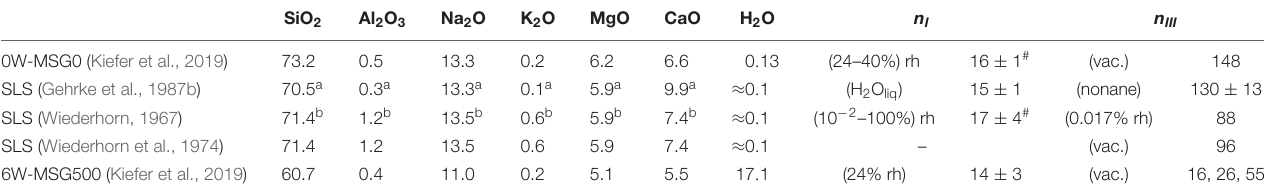
TABLE 1 | Glass composition in mol% and crack growth exponents for regions I and III. n I and n III are best fits of the data in Figures 1 , 2 with Eq. 2. SiO 2 Al 2 O 3 Na 2 O K 2 O MgO CaO H 2 O n I n III 0W-MSG0 (Kiefer et al., 2019)